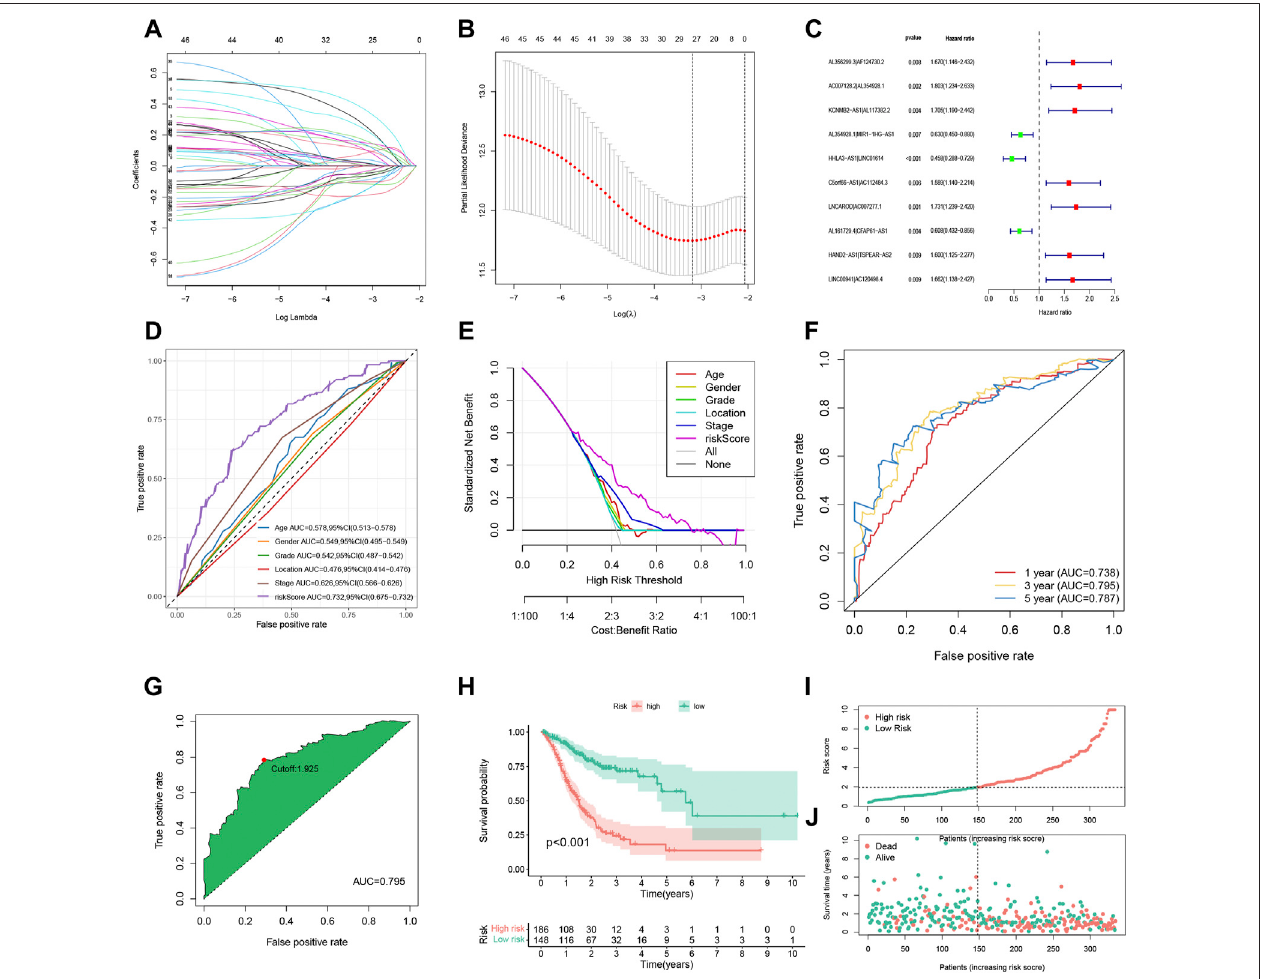
FIGURE2| ConstructionandevaluationoftheFRLPriskscoremodelinTCGAcohort. (A) Leastabsoluteshrinkageandselectionoperator(LASSO)coef fi cientsof 27prognosis-relatedFRLPs. (B) Tenfoldcross-validationfortuningparameterselectionintheLASSOmodel. (C) Forestplotshowing10FRLPsidenti fi edbymultivariate Coxregressionanalysis. (D) Receiver operatingcharacteristic(ROC)comparingtheriskscoreandotherclinicalfactorsinpredictingtotalOS. (E) Decisioncurveanalysis (DCA) curves estimating the predictive ef fi cacy of the risk score from the perspective of clinical bene fi t. The y -axis refers to the net bene fi t. The x-axis refers to the predictedOS.Theblacklinerepresentsthehypothesisthatallpatientssurvivein5 years.Thegraylinerepresentsthehypothesisthatnopatientsstayaliveformorethan 1 year. (F) ROCcurveforpredicting1-,3-,and5-yearoverallsurvival(OS)oftheFRLPriskscoremodel. (G) Cut-offpointoftheriskscoremodel. (H) Kaplan – Meierplotof high- and low-risk patients. (I) The risk score distribution. Green dots represent risk scores for low-risk patients; red dots represent risk scores for high-risk patients. (J) The relationship between survival status and risk score. The horizontalordinate represents the number ofpatients; the vertical ordinate represents risk score (AUC: area under curve; CI: con fi dence